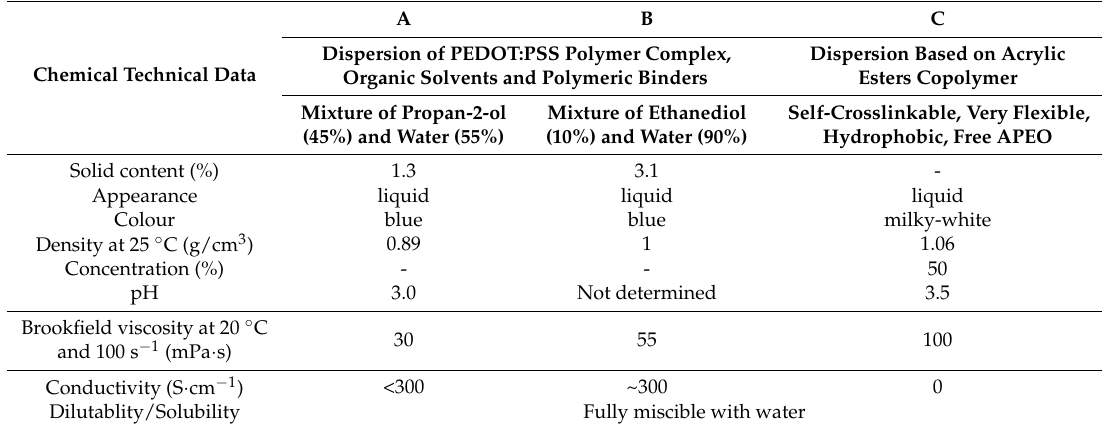
Table 4. Technical data of chemicals used for yarn coating [55–57].